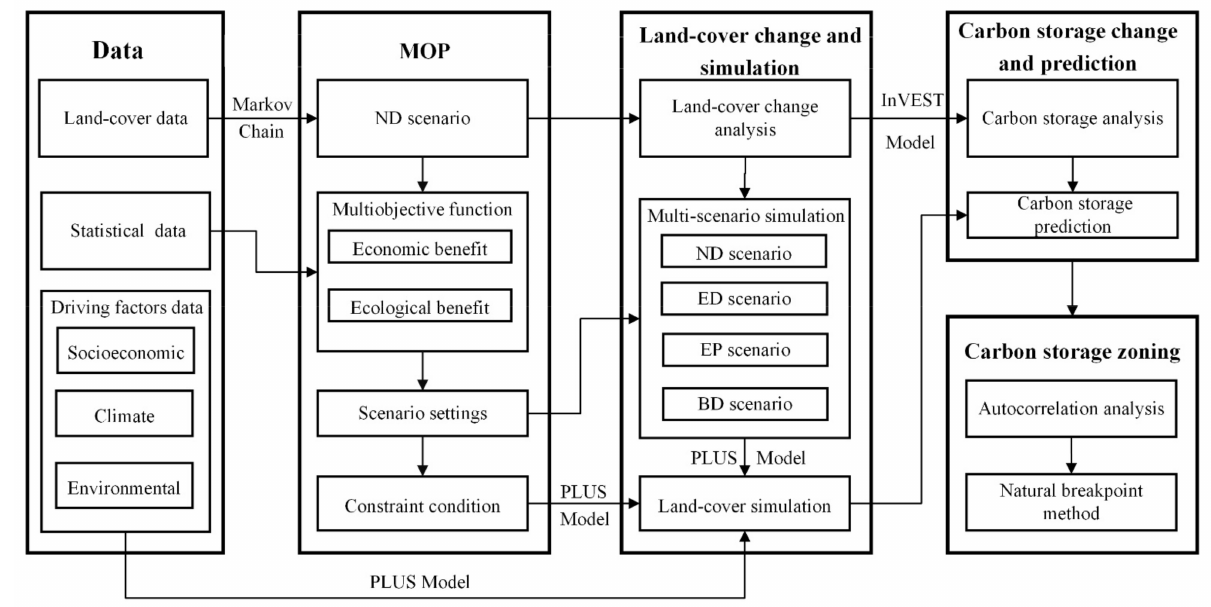
Figure 2. Research